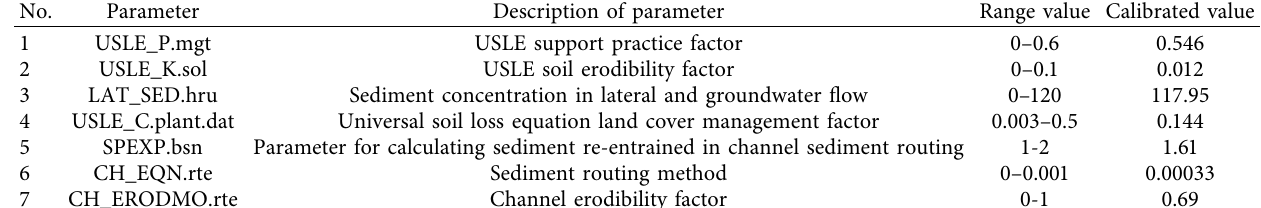
Table 9: Summary of sediment calibrated parameter values for the study area.